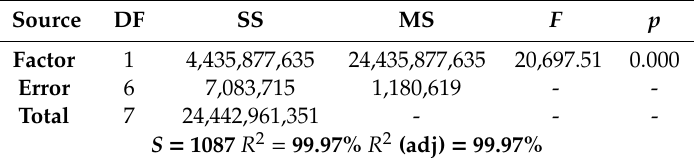
Table 1. One-way ANOVA analysis using Minitab16. Table 2. Experimental results showing the average impedance of sperm .